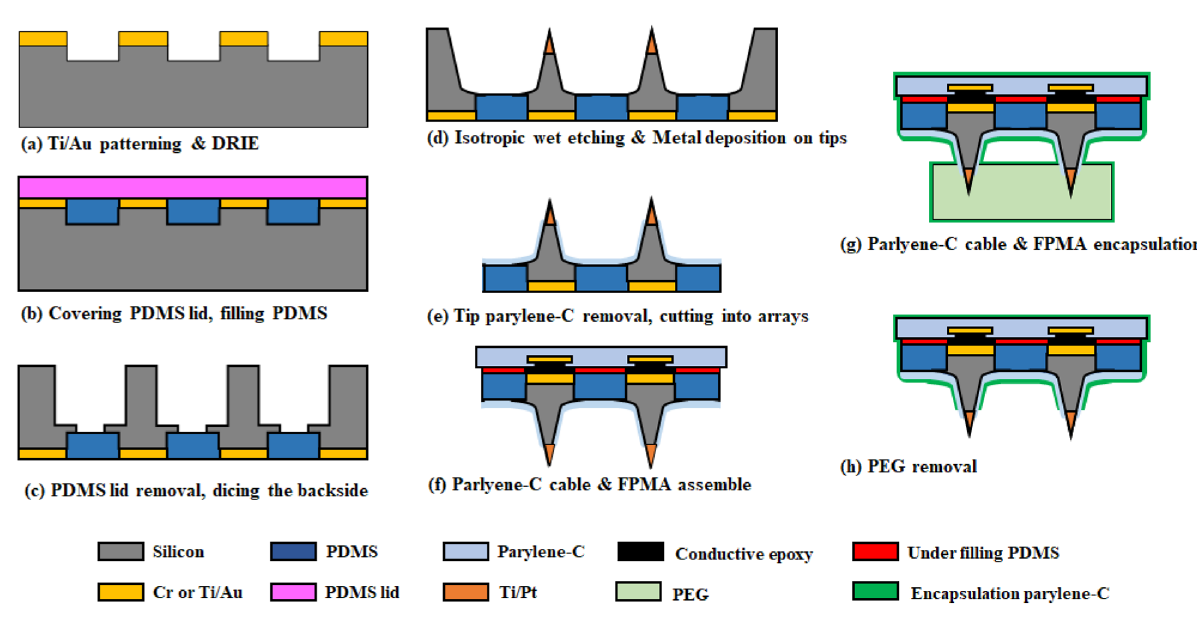
Fig. 1 Schematic illustration of the FPMA fabrication